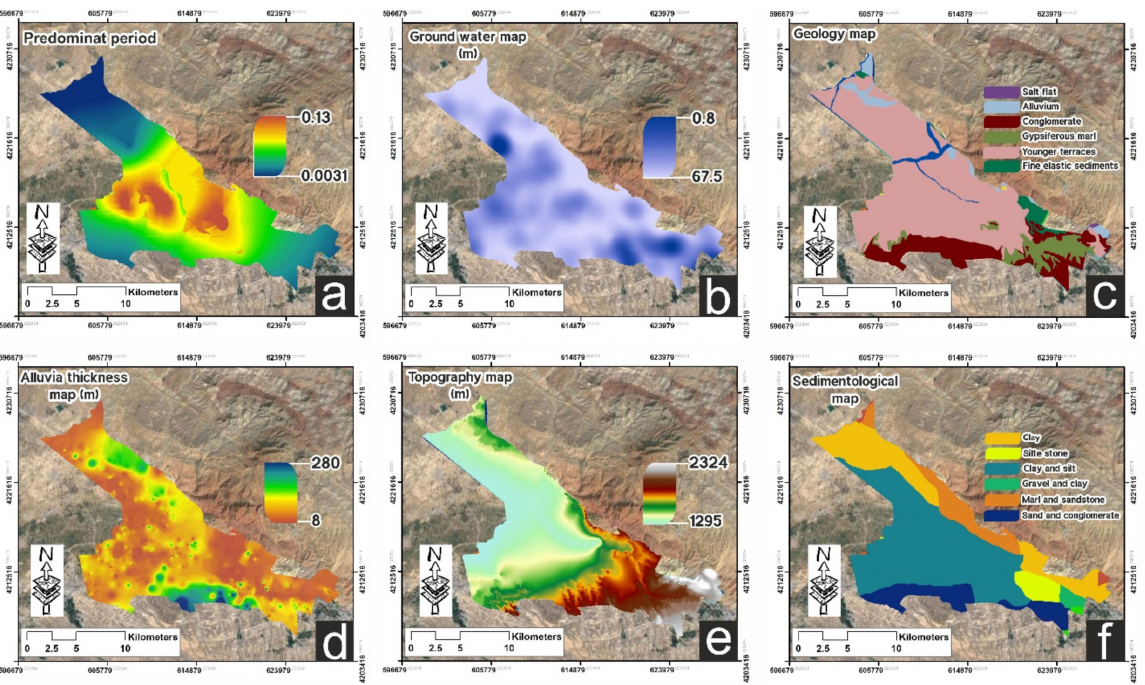
Figure 4. Effective local factors in the regions of the ten municipalities of Tabriz city. ( a ) predominant soil map; ( b ) ground water map; ( c ) geology map, ( d ) alluvial thickness map; ( e ) topography map; ( f ) sedimentology